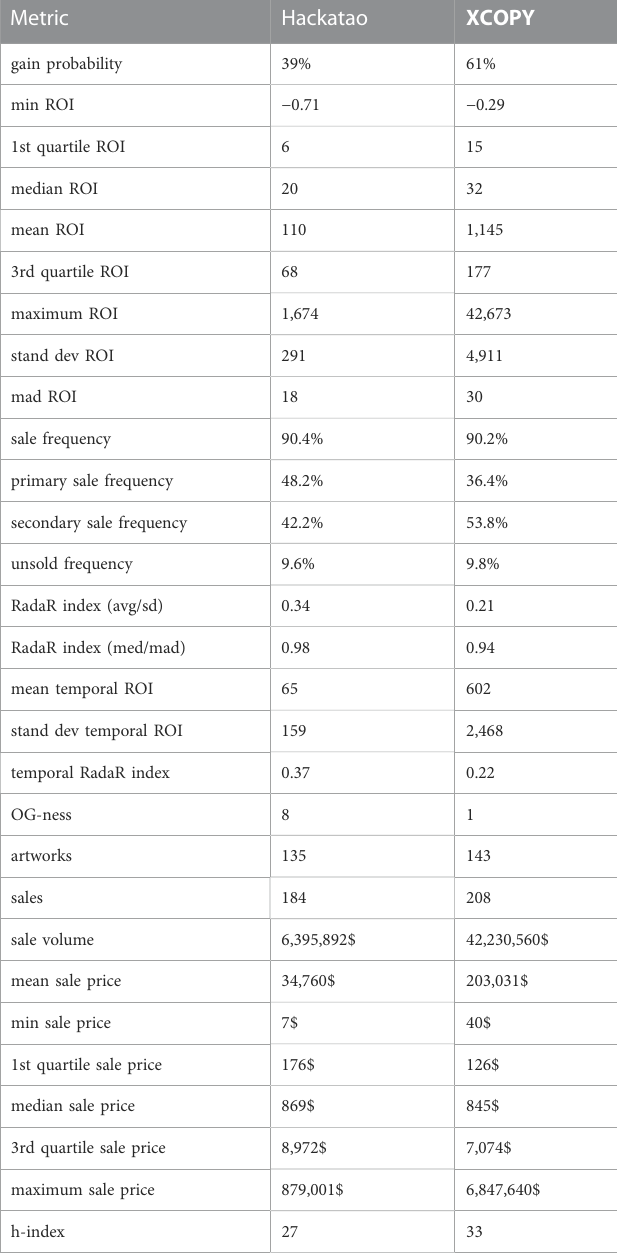
TABLE 1 Clashing Hackatao and